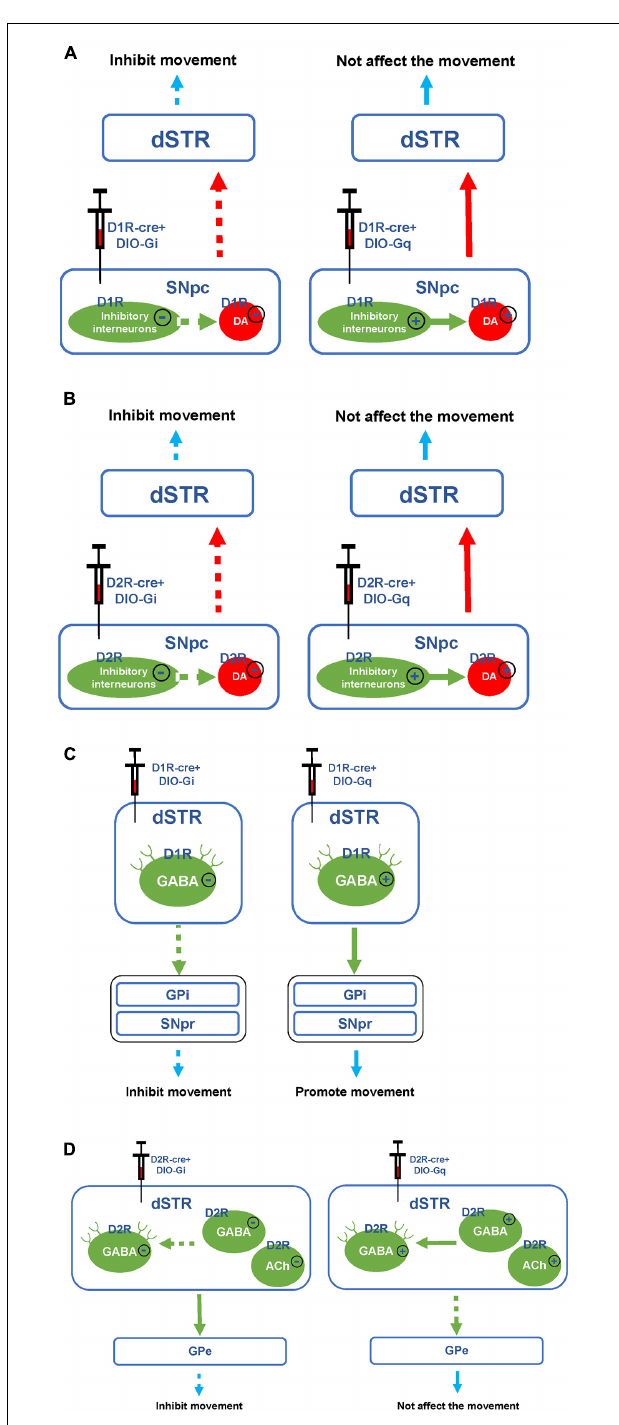
FIGURE 9 | Hypothesis diagram of experimental mechanism. (A) Hypothesis diagram of chemogenetic inhibition or activation of D1R-containing neurons in the SNpc. (B) Hypothesis diagram of chemogenetic inhibition or activation of D2R-containing neurons in the SNpc. (C) Hypothesis diagram of chemogenetic inhibition or activation of D1R-containing neurons in the dSTR. (D) Hypothesis diagram of chemogenetic inhibition or activation of D2R-containing neurons in the dSTR. The solid line or plus sign indicates activation. The dashed line or minus sign indicates